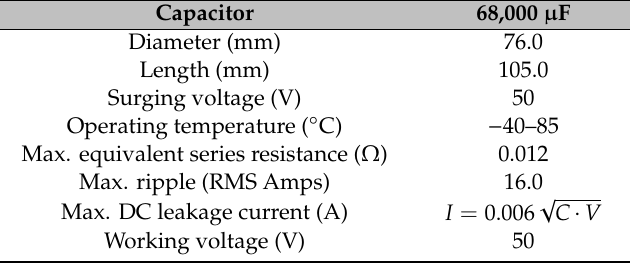
Table 1. Specification of capacitor applied.